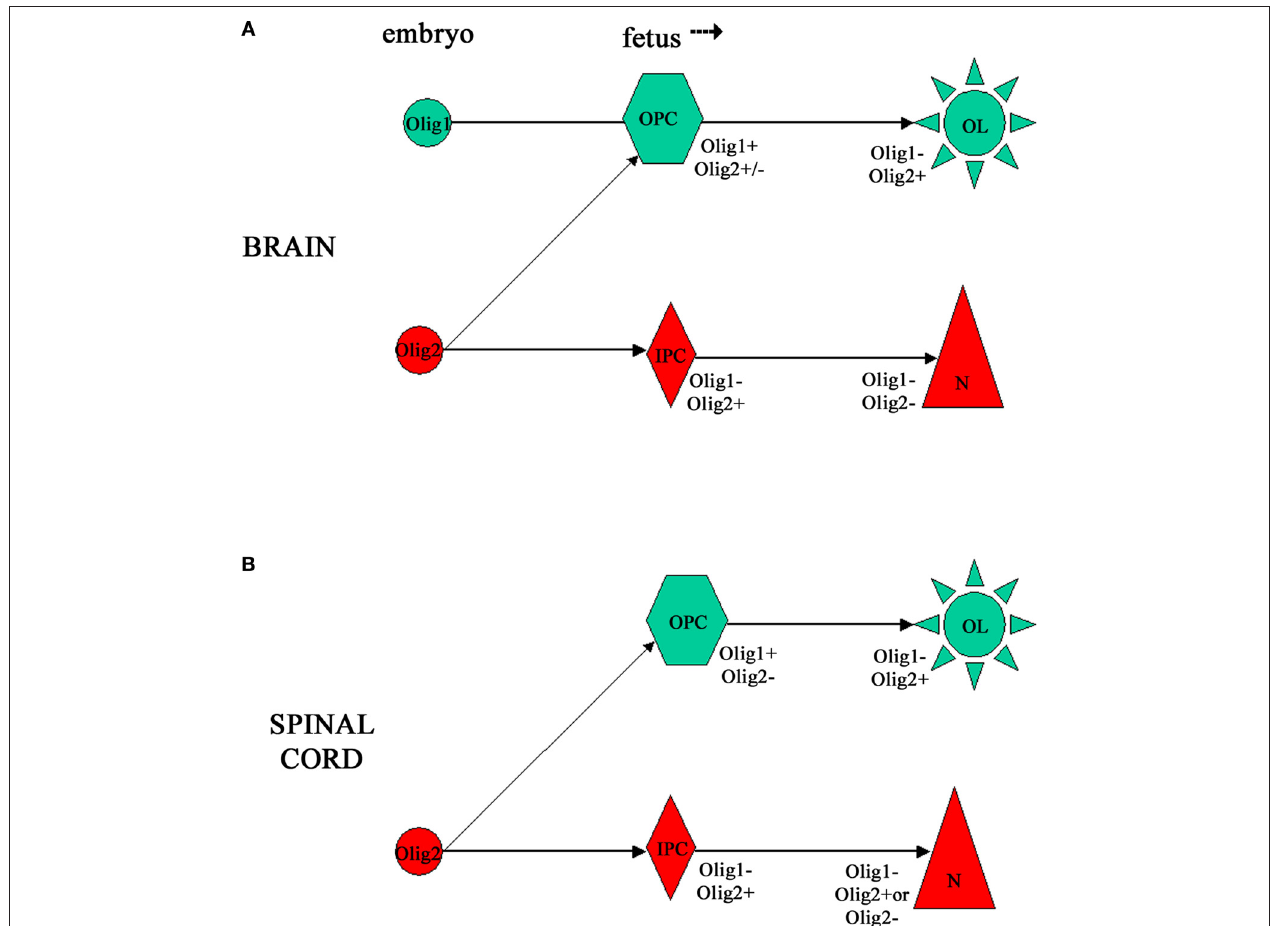
FIGURE 7 | Schematic representation of possible lineage relationships between neurons and oligodendrocytes linked via Olig transcription factors in human CNS development, based on our results (Jakovcevski and Zecevic, 2005b). (A) In the embryonic forebrain Olig1 and Olig2 appear to be expressed by separate progenitor cell pools, and our evidence suggests that Olig2 + progenitors give rise to neurons. Later during fetal development early